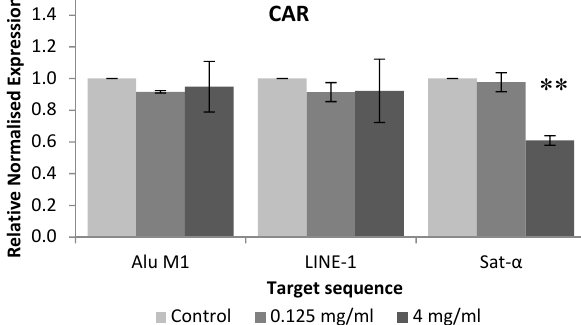
Figure 5. Relative normalised expression data of each repetitive element. Asterisk mark (*) is associated with different means, applying One-Way Anova test and post hoc Tuckey’s test.